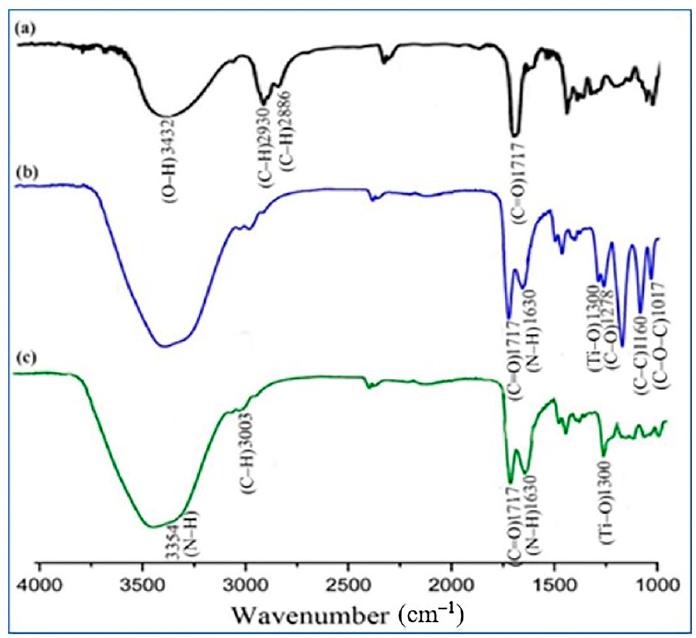
Figure 1. FTIR spectra of (a) PHEMA, (b) PHEMA/A/TiO 2 , and (c) PHEMA/G/TiO 2 hybrid scaf-